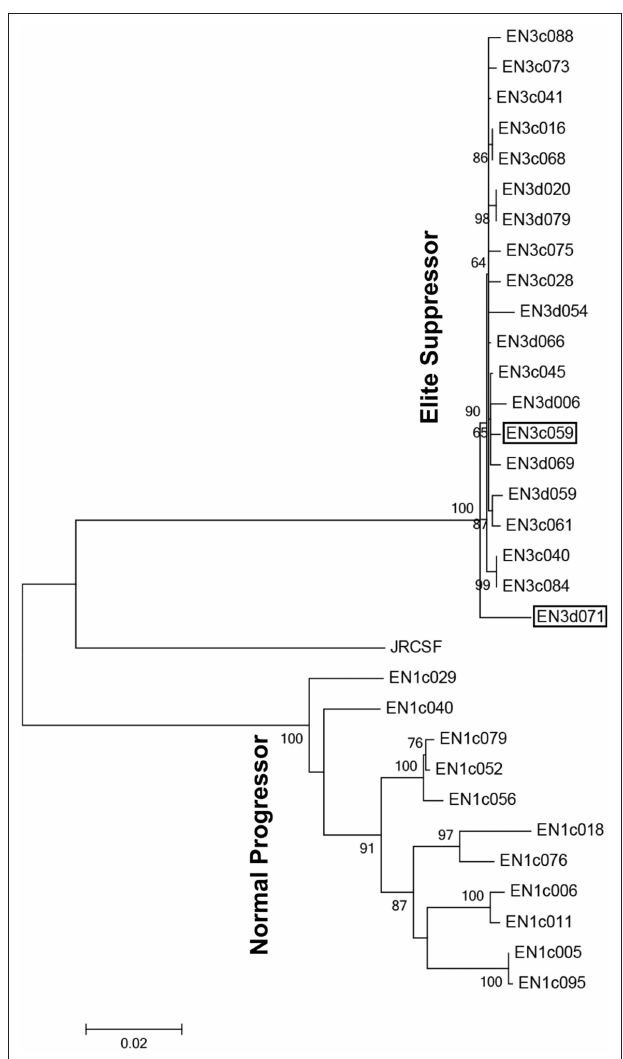
FIGURE 1 | Phylogenetic analysis of proviral sequences isolated from an elite suppressor (EN3) and a normal progressor (EN1) that both possess bNAbs. Proviral sequences were recovered from two individuals (EN1 and EN3) using the Monogram Phenosene ® assay system. Evolutionary analyses were conducted in MEGA6 using a Maximum Likelihood method with 1000 bootstrap replicates and a discrete Gamma distribution to model evolutionary rate. The tree is drawn to scale, with branch lengths measured in the number of substitutions per site. Sequences used in mutagenesis studies, EN3d071 and EN3c059, are shown with a black